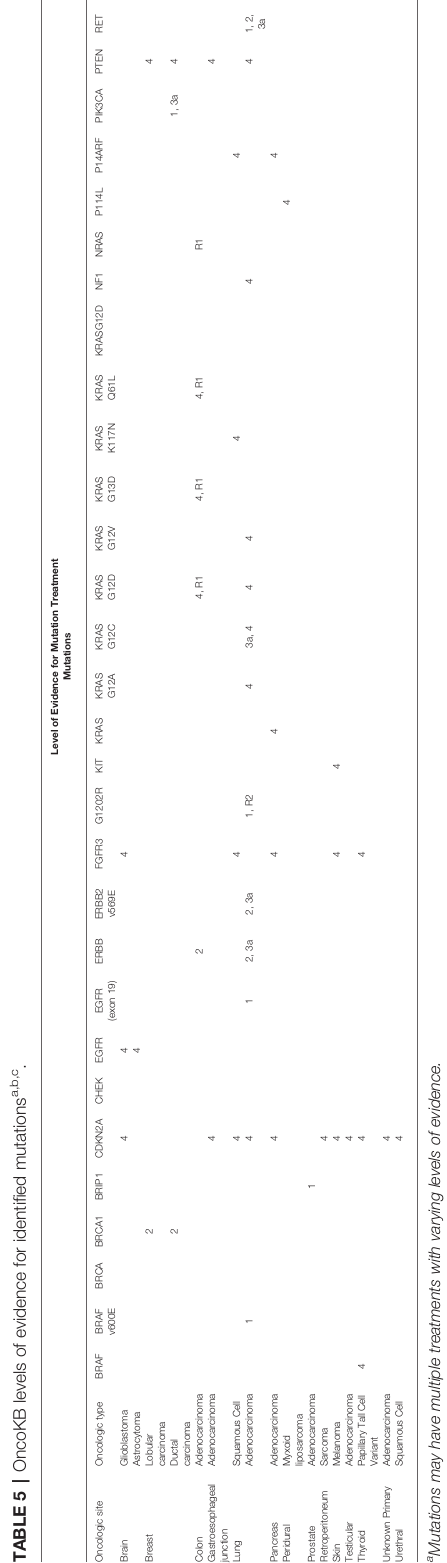
TABLE 4 | Summary of oncogenic mutations identi fi ed in FM report. Oncogenic mutation Number of incidences Percentage